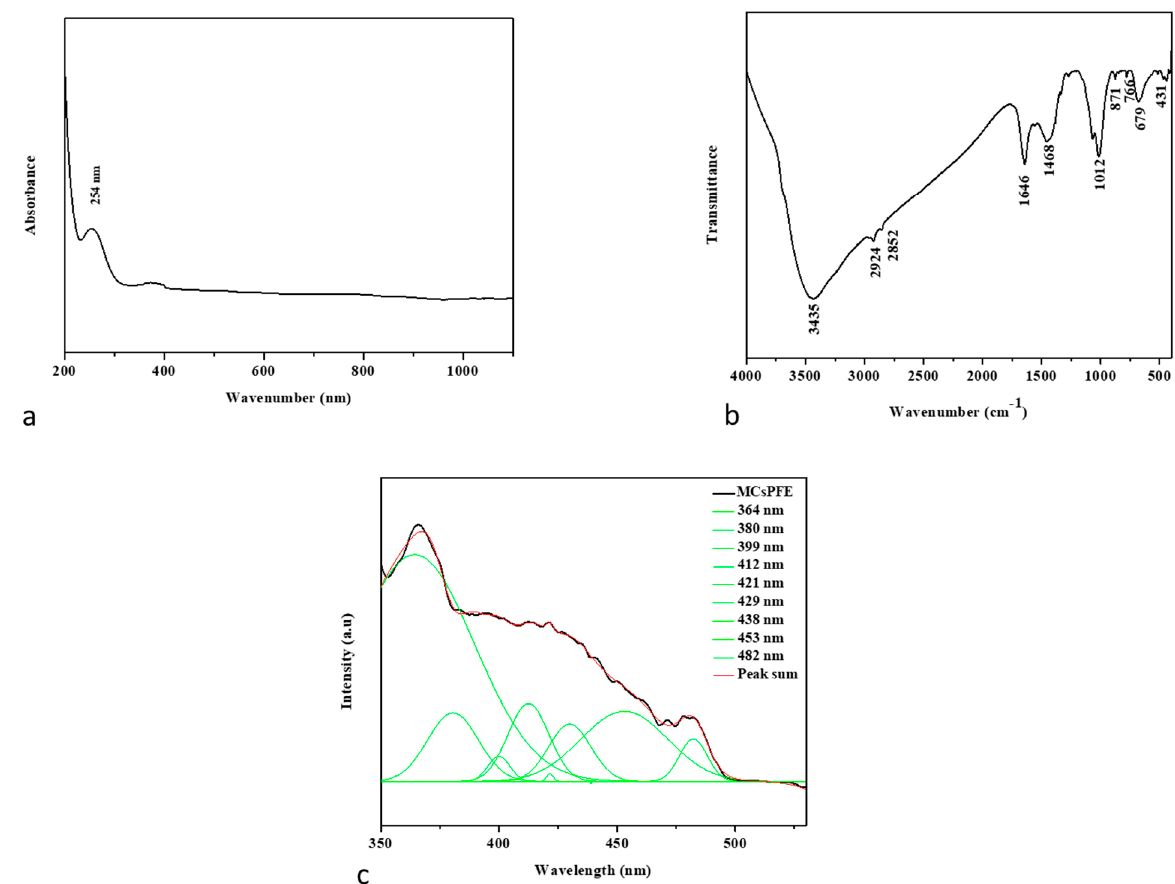
Figure 1. Spectral analysis of MgO-Chitosan-Pluronic F127-Escin NPs. UV-Vis spectrum of MgO-Chitosan-Pluronic F127-Escin NPs ( a ). FTIR Transmittance vs. wavenumber chart of MgO-Chitosan-Pluronic F127-Escin NPs derived from infrared analysis ( b ). Photoluminescence spectra for MgO-Chitosan-Pluronic F127-Escin NPs at room temperature ( c ).